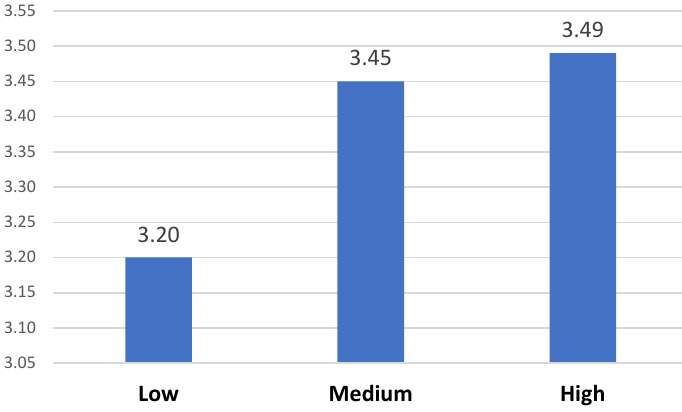
Figure 2. Levels of FoMO 2 based on perceived phubbing levels.